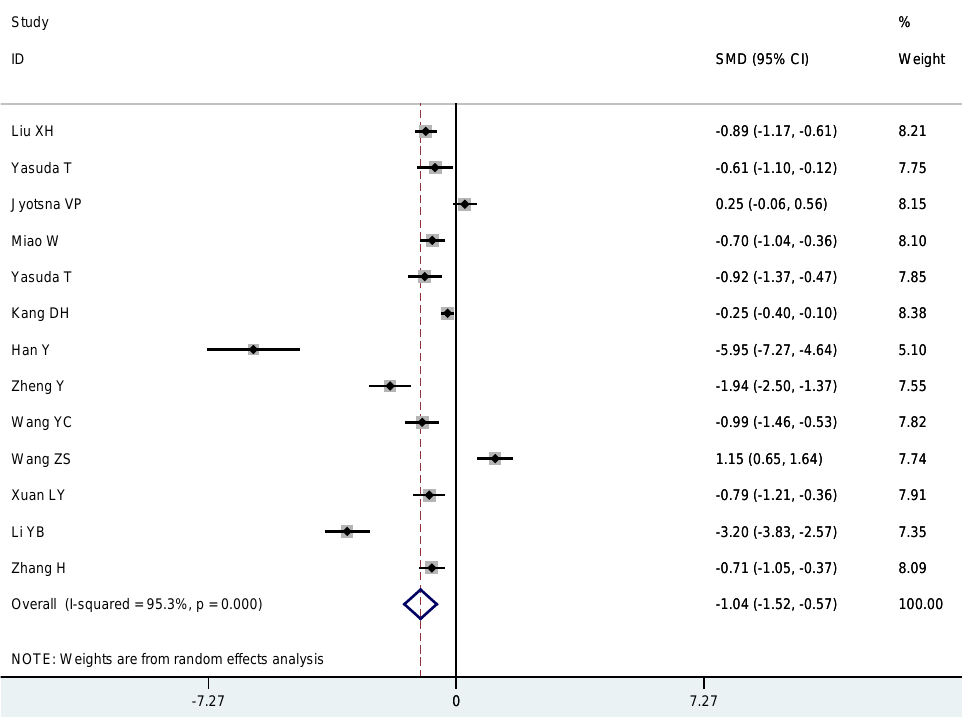
Figure 3. Meta-analysis of studies (chronologically ordered) reporting dichotomous data on 25(OH)D levels in autoimmune thyroid disease (AITD) vs. controls and estimated odds ratios (ORs) with 95% confidence interval.